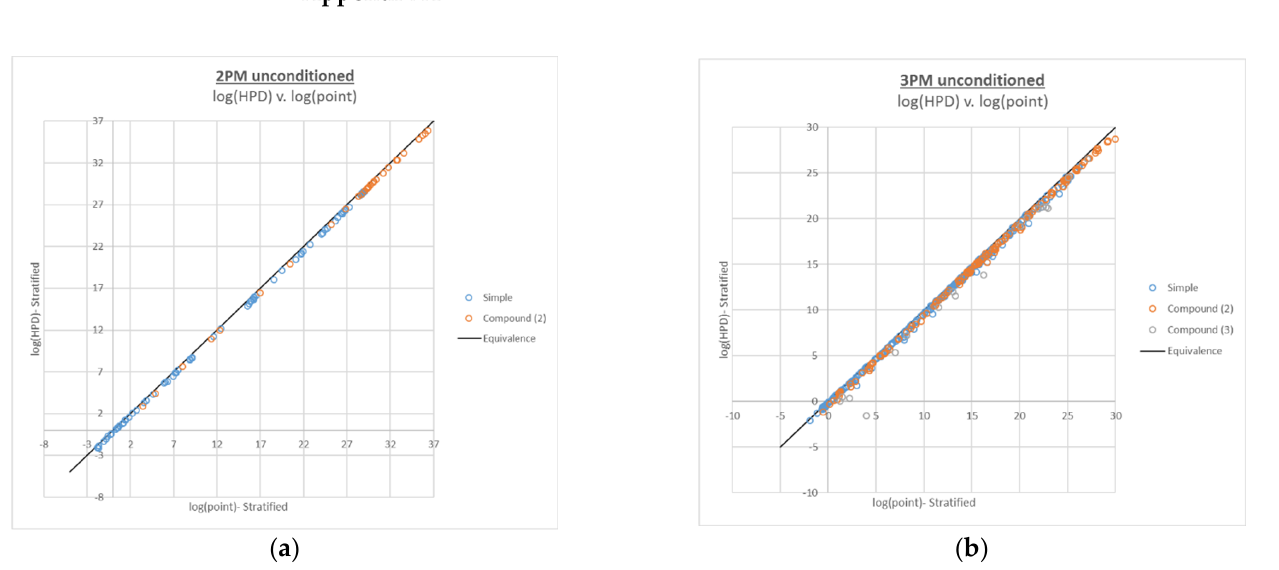
Figure A1. Plots of log(HPD LR) v. log(point estimate LR) for 2-person ( a ) and 3-person ( b ) compound LR calculations.